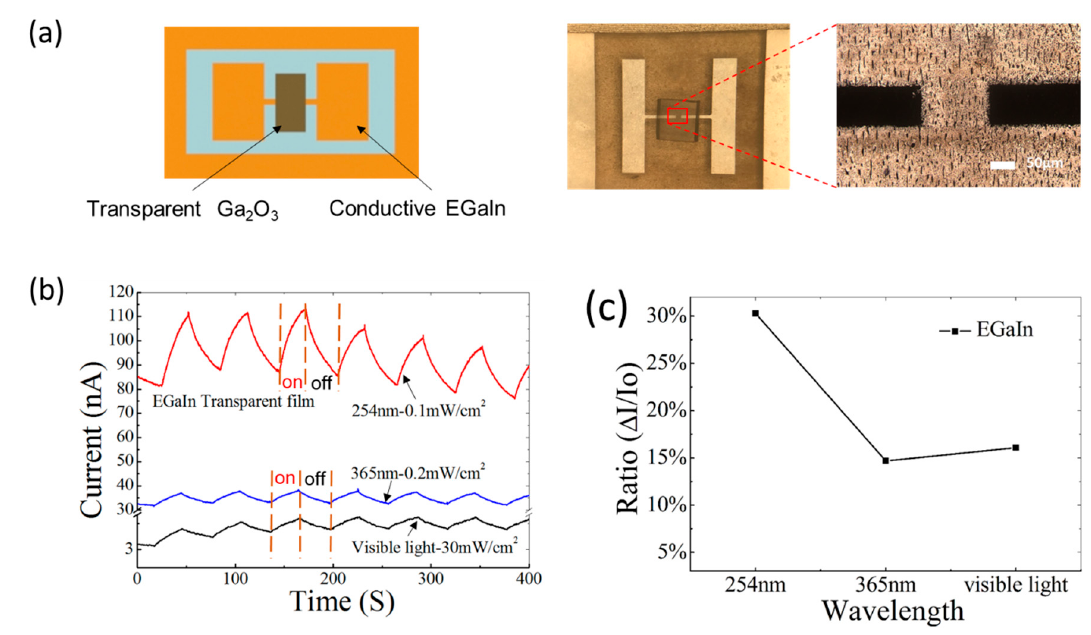
Figure 4. ( a ) Images of the photodetector combined with the conductive electrode and photo-responsive film; ( b ) Time-dependent photo-response curves and ( c ) photo-response-current ratios of the photodetector under illumination with ultraviolet light ( λ ~254 nm and 365 nm) and visible light. The bias voltage was 0.1 V, and the on/off time of lights was 30 s/30 s. It is known that Ga 2 O 3 has a wide bandgap (4.5~4.9 eV) at room temperature [46,47]. As a result, the device is used to measure ultraviolet and visible light as a high-range photodetector. As shown